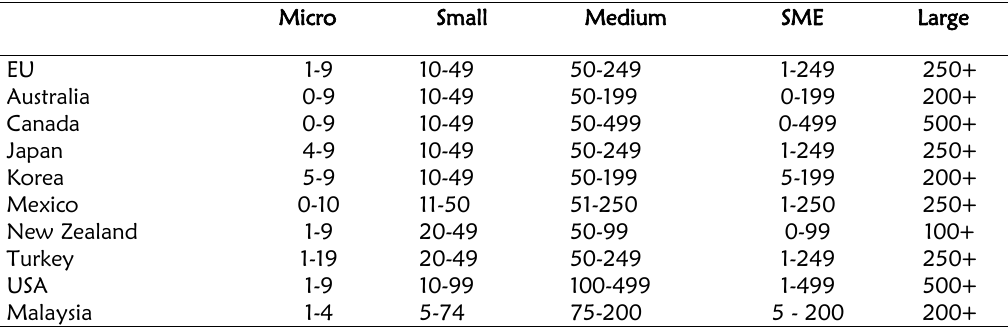
Table 1: Size of Firms by Number of Employees in different